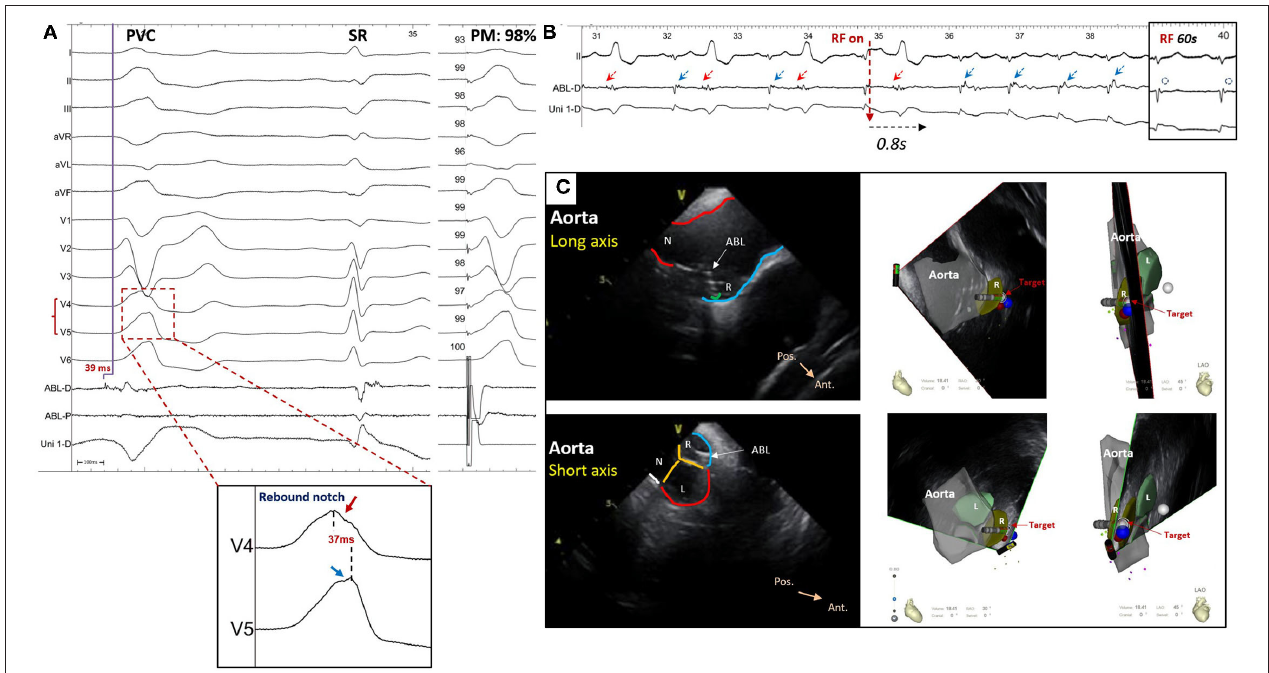
FIGURE 5 | A patient who suffered from premature ventricular contraction (PVC) with left bundle branch block morphology and inferior axis deviation ablated in the right-anterior ASV. (A) The ECG of PVC showed a rebound notch on leads V4-V5; the final target revealed a reversal potential (compared with sinus rhythm) that preceded the onset of QRS for 39ms during PVC and the pace mapping showed a similarity of 98%. (B) The ventricular bigeminy rhythm disappeared immediately after radiofrequency (RF) initiation and the late potential (blue arrow) during sinus rhythm was eliminated after 60s of RF. (C) The ablated target was located at the right-anterior ASV through intracardiac echocardiography. ABL-D/P, distal or proximal bipolar electrogram; Uni-D, distal unipolar electrogram; SR, sinus rhythm; PM, pace mapping; ABL, ablation catheter; ASV, aortic sinus of Valsalva; N, non-coronary ASV; L, left ASV; R, right ASV; Pos., posterior; Ant.,